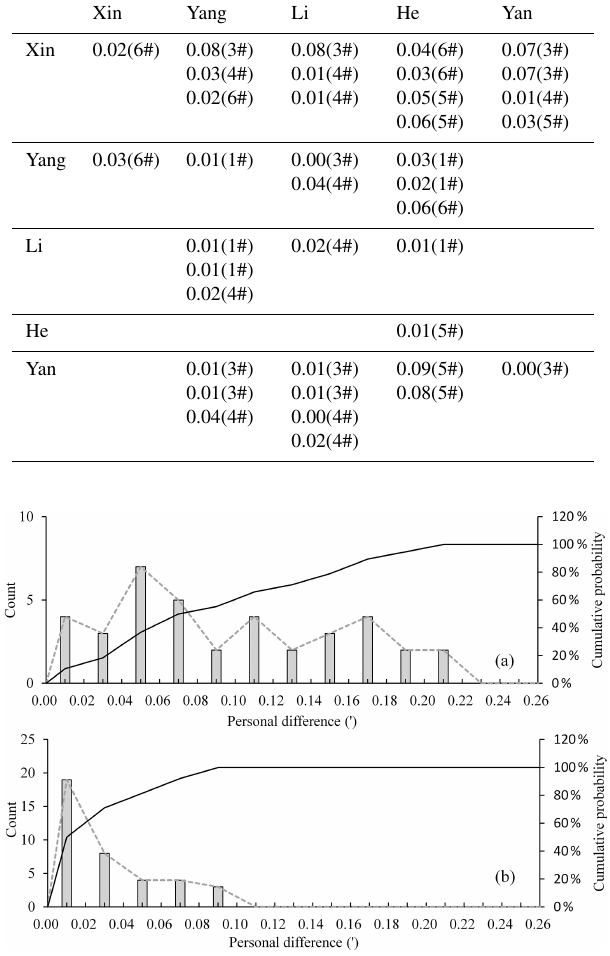
Figure 5. The frequency distribution and the cumulative probabil- ity for the declination (a) and inclination (b) . The histogram is the count of the operator differences. The dotted line and the solid line represent the frequency distribution (corresponding to the left verti- cal axis) and the cumulative probability (corresponding to the right vertical axis),